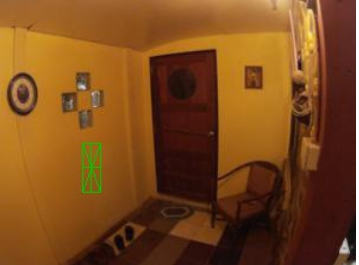
Figure 10. “Star of thickness 1 surrounded by a rectangle”.